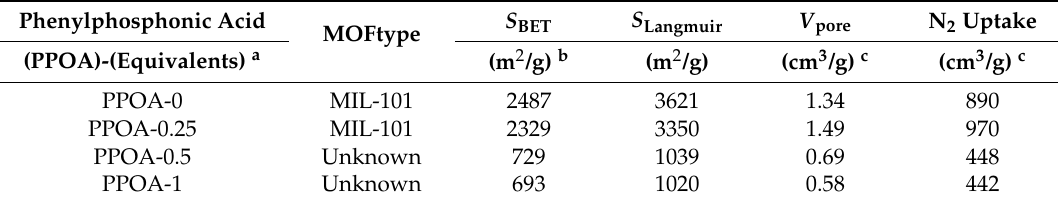
Table 1. Yield, surface area, and pore volume for MIL-101(Cr) with various amounts of phenylphosphonic acid (PPOA) as additive.